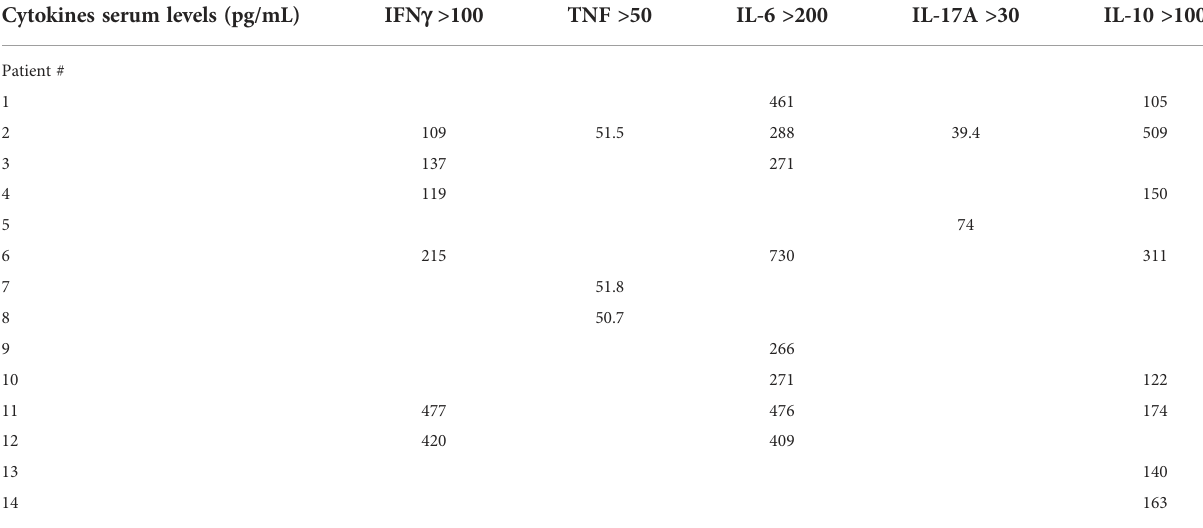
TABLE 2 MIS-C patients with the highest levels of serum cytokines. Cytokines serum levels